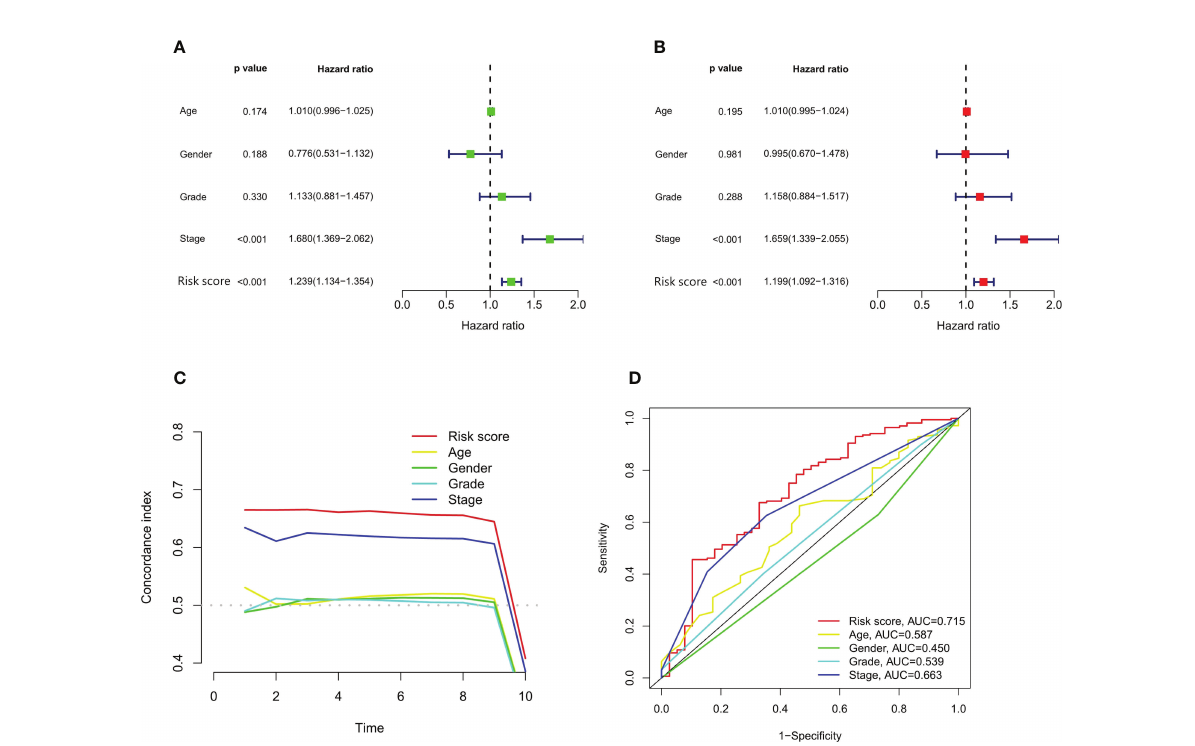
FIGURE 5 Independent prognostic analysis of the risk model. Forest plots of univariate (A) and multivariate (B) Cox regression analyses of the risk score and clinical characteristics. Concordance indexes (C) and ROC curve analysis (D) of the risk score and clinical